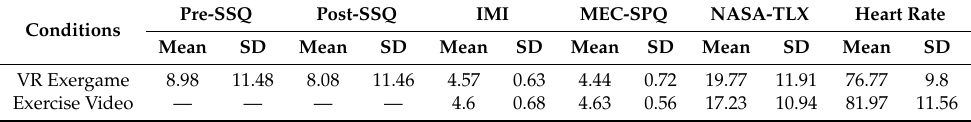
Table 1. The descriptive values of the questionnaire measures and heart rate for both conditions. Pre-SSQ Post-SSQ IMI MEC-SPQ Conditions